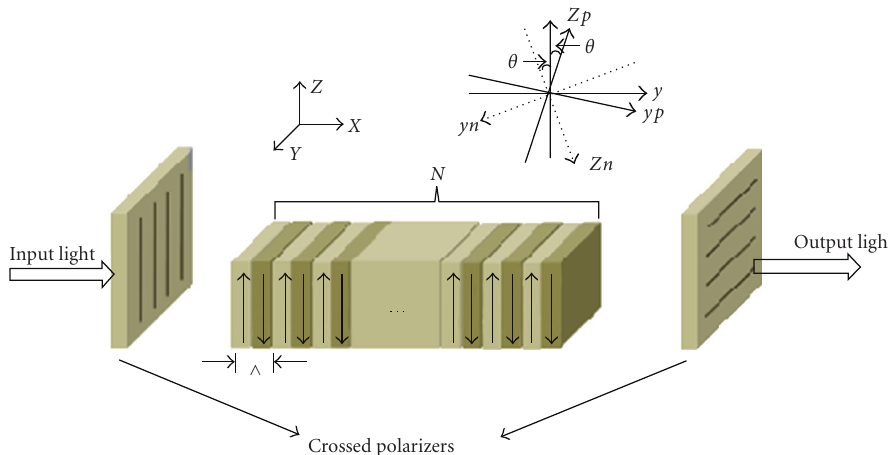
Figure 1: The schematic diagram of folded ˇSolc-type wavelength filter. M couples of half-wave plates are held in two crossed polarizers. The optic axes of the plates aligned at angles + θ and − θ with respect to the Z axis in every